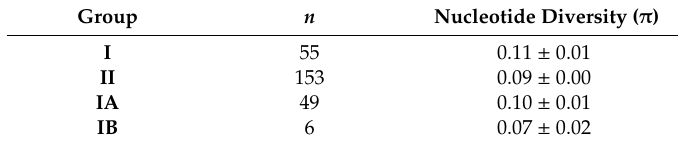
Table 4. Nucleotide diversity ( π ) of Bov-B LINE retrotransposon groups with outgroups excluded.